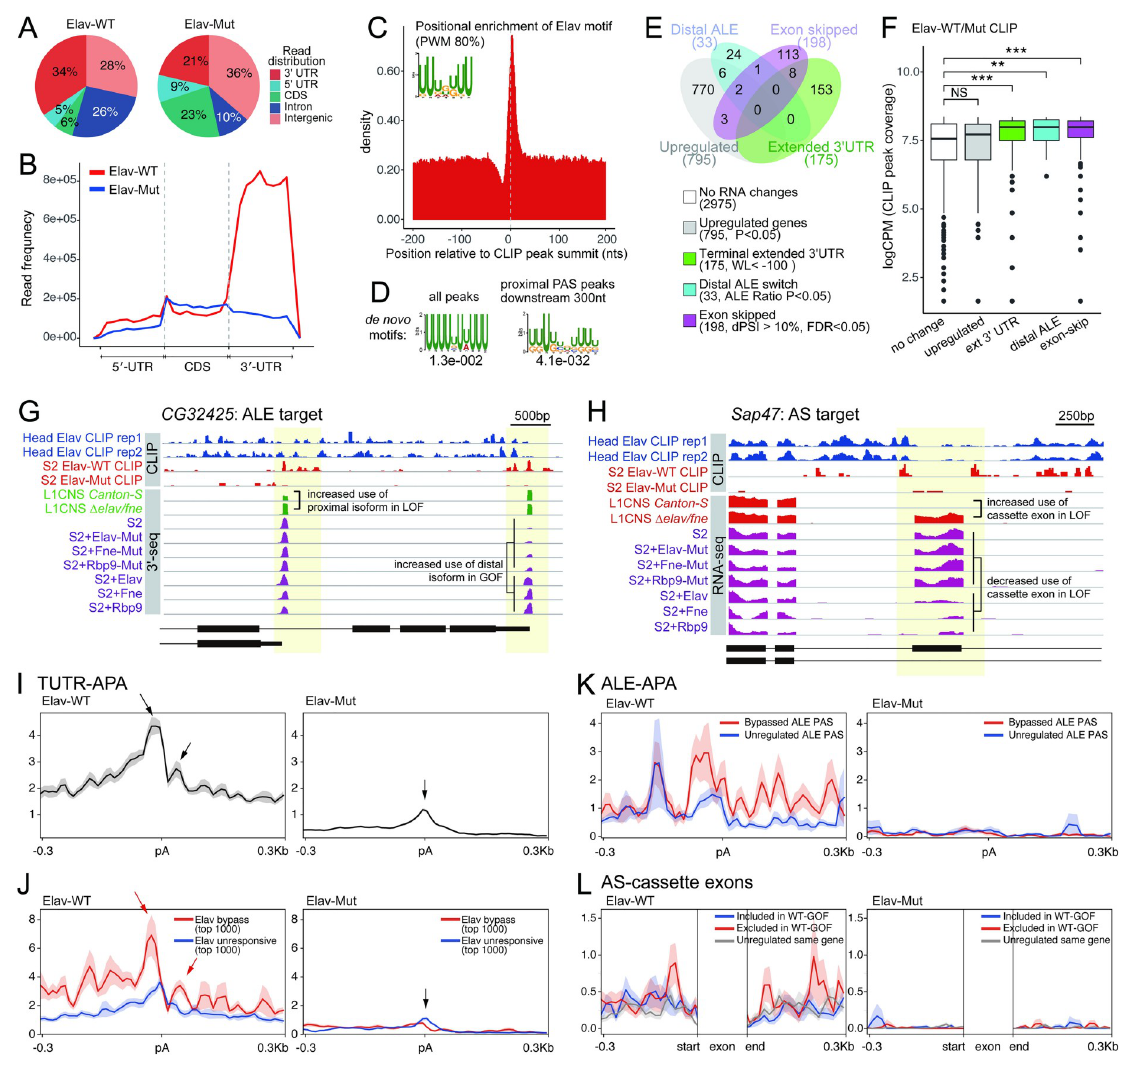
Fig 7. Genomic analysis of RRM-dependent Elav binding in S2 cells. (A) We used BrdU-CLIP to profile wildtype (wt) and 3xRRM-mut (Mut) Elav expressed in S2 cells. Pie charts show the genomic distribution of WT and 3xRRM-mut (Mut) Elav CLIP-seq reads. (B) Metagene profiles of WT and Mut Elav CLIP-seq read distribution across the transcriptome of S2 cells. (C) Positional distribution of the Elav motif within CLIP peak clusters. Sequences that match � 80% PWM are enriched at CLIP peak summit. (D) De novo sequence motifs enriched within the transcriptome (left) or 300 nt downstream of proximal pA sites from CLIP peak clusters. (E) Venn diagram of four classes of genes that are altered by expression of wildtype-ELAV/Hu RBPs shows they are mostly non-overlapping. (F) CLIP peak coverage of each of the four categorized genes. Coverage of CLIP peaks spanning in the whole gene body including introns are defined as the coverage of a give gene. Genes that are upregulated in the presence of ELAV/Hu factors exhibit similar Elav-CLIP binding as bound genes lacking RNA changes, but 3’ UTR extension, distal ALE switching, and exon-skipping targets all show elevated binding of Elav in aggregate. (G-H) IGV browser views of representative Elav/Hu-regulated ALE (H) and cassette exon exclusion (H) targets. (I-L) Metagene profiles of Elav-WT and Elav-Mut CLIP clusters in the vicinity of regulated isoform sites. (I) All pA sites in terminal 3’ UTRs. (J) Segregation of pA sites that are most or least responsive to ectopic ELAV/Hu proteins. (K) Analysis of Elav binding at ALE 3’ ends, segregated by sites that are bypassed or unaffected by ectopic ELAV/Hu proteins. (L) CLIP signals from 300 nt upstream of the 3’-splice site and downstream of the 5’- splice site of alternatively spliced cassette exons regulated by ELAV/Hu RBPs. These are segregated as to exon exclusion or inclusion, and all other exons of the same genes are plotted as controls. Metaplots in I-L show average profiles and standard errors for the indicated sets of loci. ( Fig 7E ). We analyzed the distribution of Elav CLIP binding to these groups of genes, com- pared to other loci with Elav binding that otherwise had no RNA changes. Interestingly, although mammalian ELAV/Hu RBPs are involved in RNA stabilization [35,61,62], we find